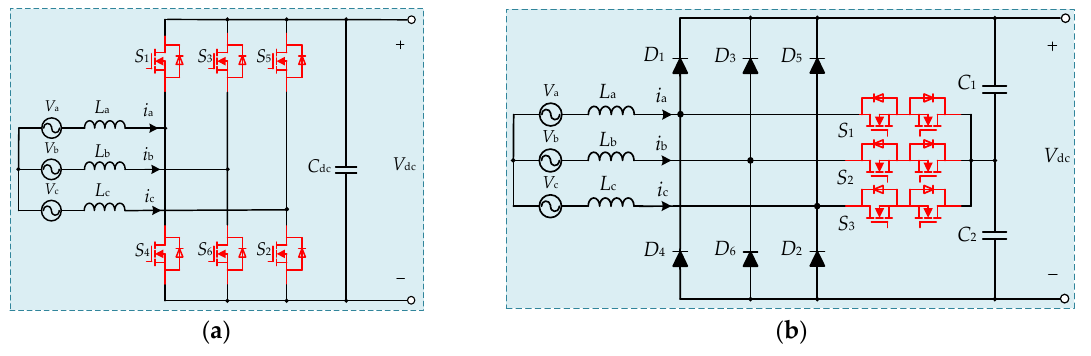
Figure 6. Three-phase boost-type recti fi er topology. ( a ) Three-phase six-switch boost recti fi er. ( b ) Vienna recti fi er.